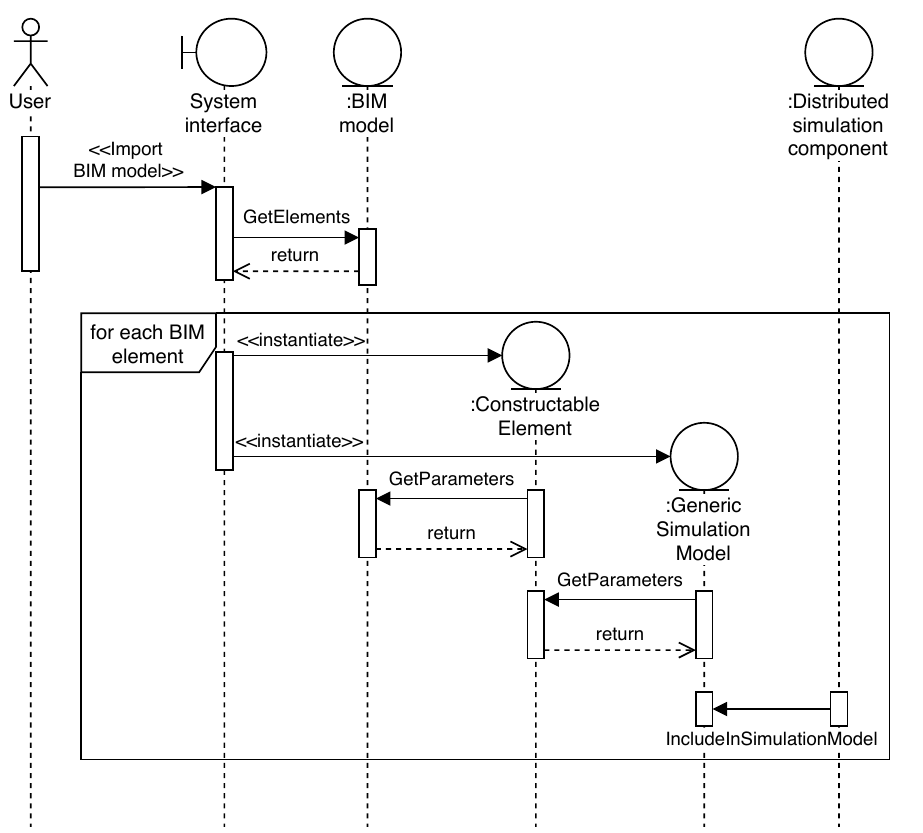
Figure 9. Distributed simulation component sequence